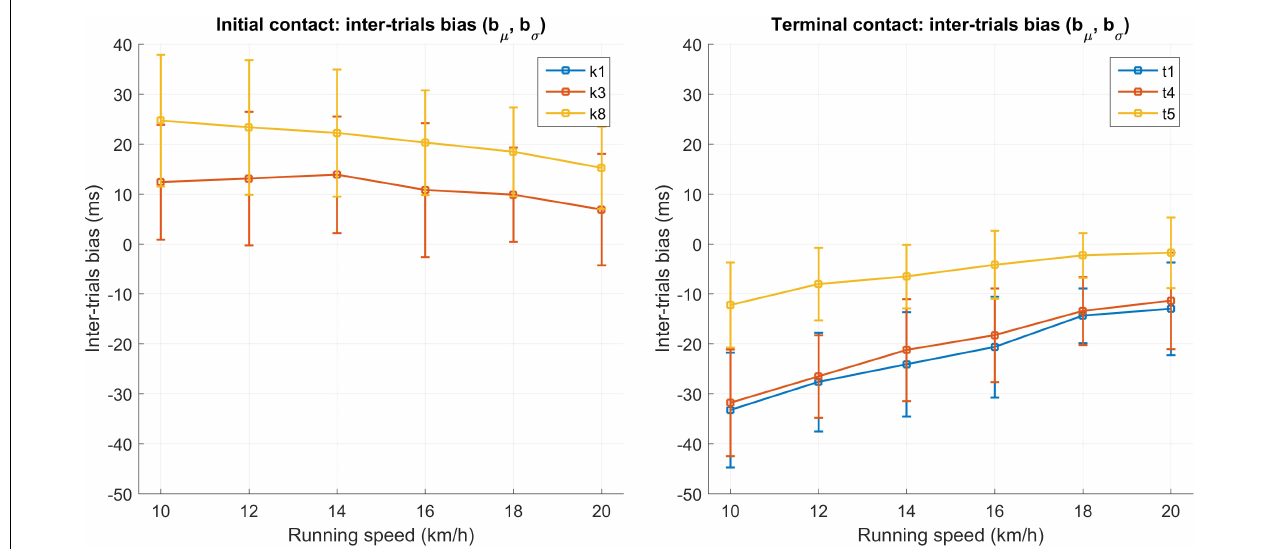
FIGURE 3 | Initial contact (left graph) and terminal contact (right graph) inter-trials bias for the features (k 1 , k 3 , k 8 ) and (t 1 , t 4 , t 5 ), respectively. The graph was computed using the complete data set (development set and validation set) and using the reference threshold on the vertical GRF at 7 %BW. Each group of speed contains N = 35 trials except the 20 km/h group where N =